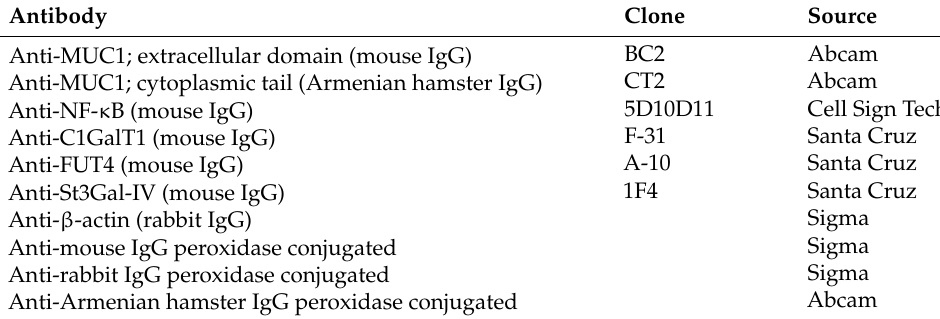
Table 3. Antibodies used in Western